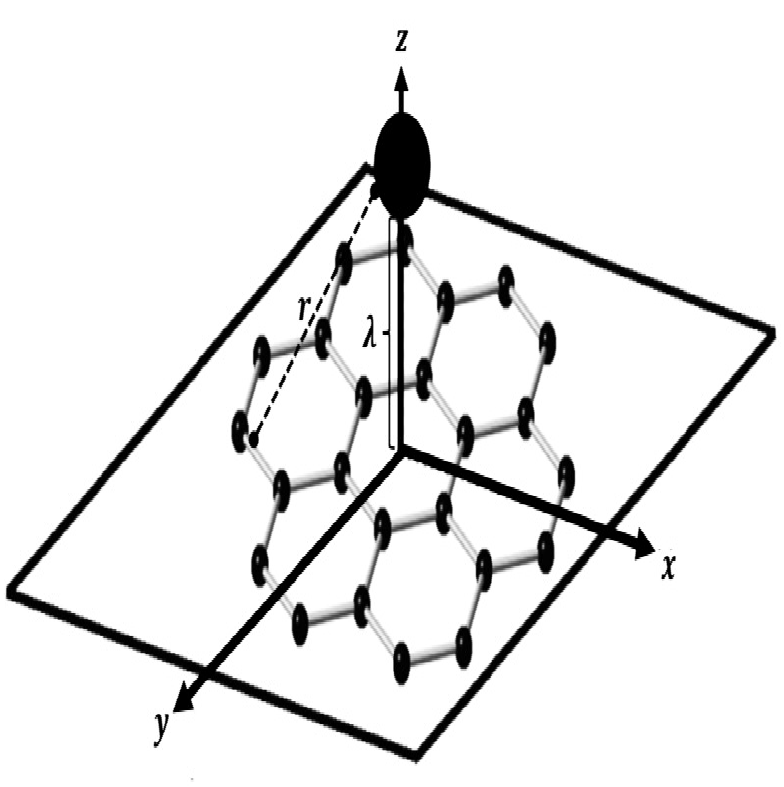
Figure 2. A sketch of the interaction between metal atoms and nanosheet. Table 1. Approximate Lennard–Jones attractive and repulsive